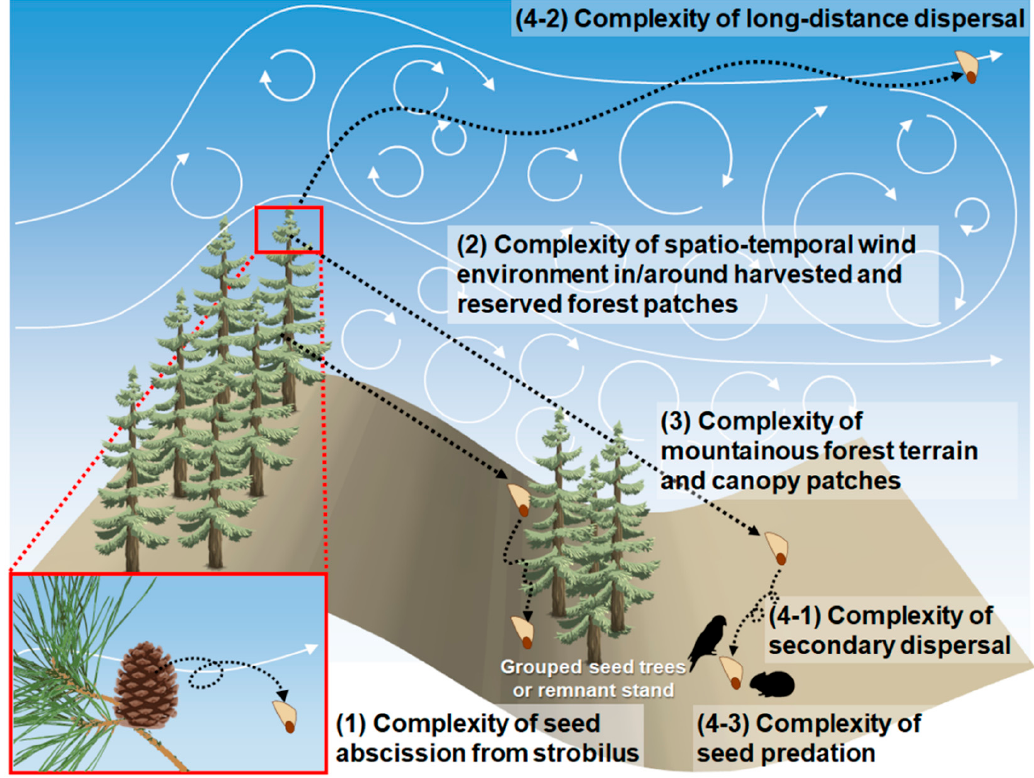
Figure 3. Challenges in seed dispersal modeling for natural regeneration estimation, especially in managed forest stands on mountainous terrain.